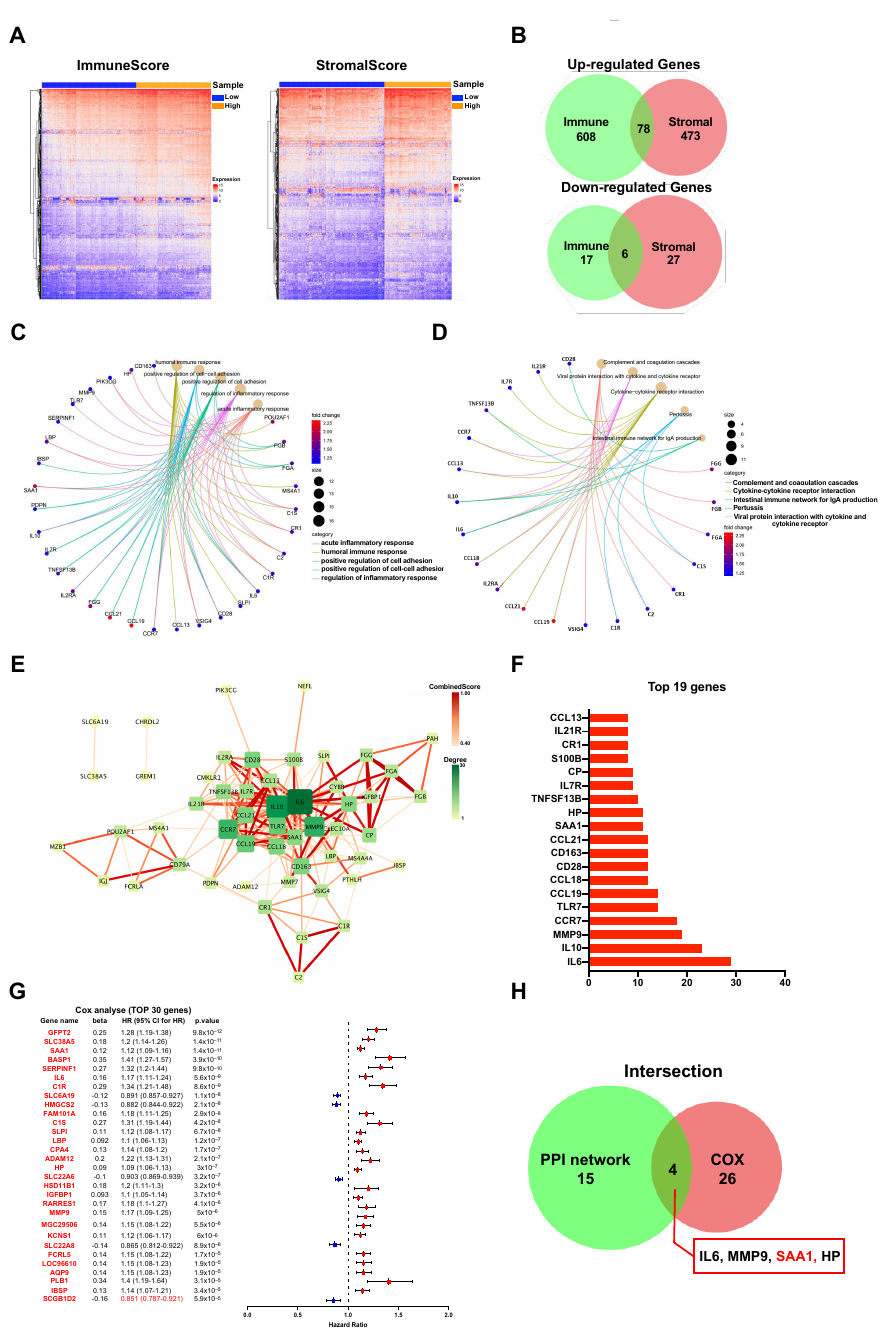
Figure 3. Screening of DEGs (Differentially expressed genes), GO, KEGG, and protein–protein interaction (PPI) enrichment analysis. ( A ) Heatmap showing the expression levels of DEGs between the high-score group and low-score group by ImmuneScore and StromalScore. (DEGs were determined by calculating the adjusted p < 0.05 and |log 2 FC| > 1 as the thresholds). ( B ) Venn plots demonstrated a total of 84 DEGs (78 up-regulated DEGs and 6 down-regulated DEGs) shared by ImmuneScore and StromalScore ( p < 0.05 and |log 2 FC| > 1). ( C , D ) GO and KEGG pathways enrichment analysis for the 84 DEGs; both p value and q value < 0.05 were considered to be significantly enriched. ( E ) PPI network constructed with the nodes with interaction confidence value > 0.60. ( F ) The 19 genes with the most connected nodes in the network. ( G ) Top 30 significant genes with univariate COX regression analysis with 84 DEGs ( p < 0.0001). ( H ) Venn plot depicting the 4 overlap genes (IL6, MMP9, SAA1, and HP) between the top 19 nodes in PPI and the top 30 significant genes correlated with